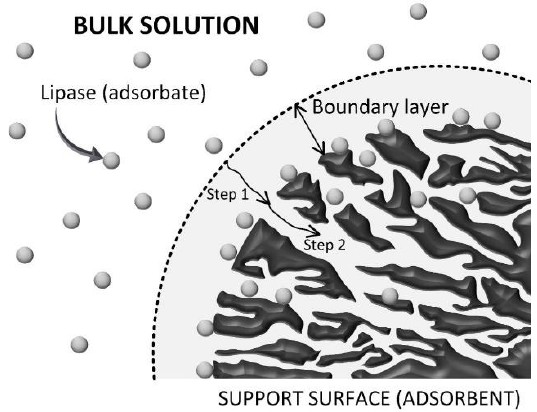
Figure 3. Representative scheme of the mechanism of lipase adsorption on PSty-DVB beads. Step 1